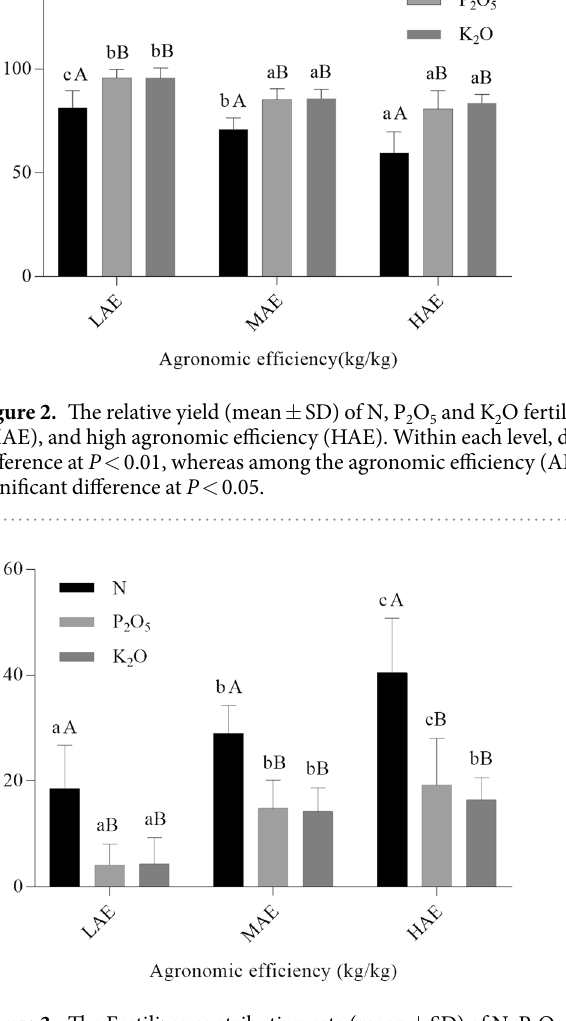
Figure 3. The Fertilizer contribution rate (mean ± SD) of N, P 2 O 5 and K 2 O at low (LAE), medium (MAE), and high agronomic efficiency (HAE). Within each level, different capital letters indicate a significant difference at P < 0.01, whereas among the agronomic efficiency (AE) levels differing lower-case letters indicate a significant difference at P <